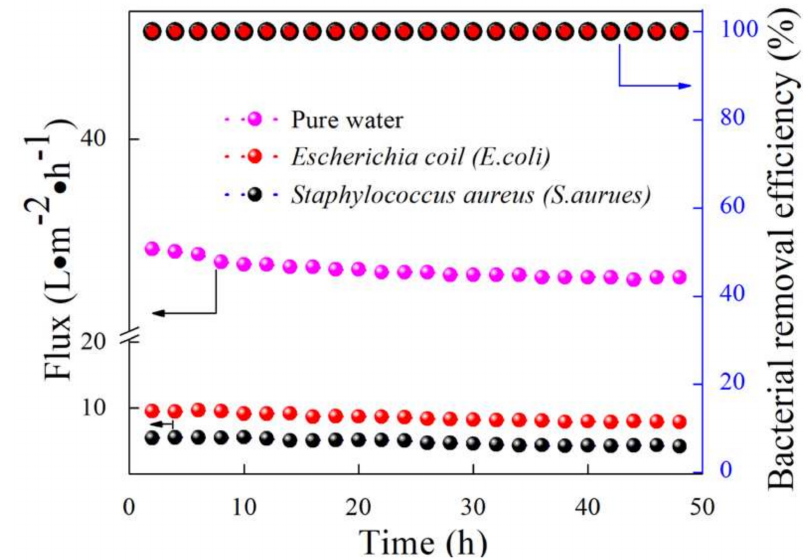
Figure 7. Flux and bacterial removal efficiency, as a function of the operation duration, of the mullite-CNTs composite